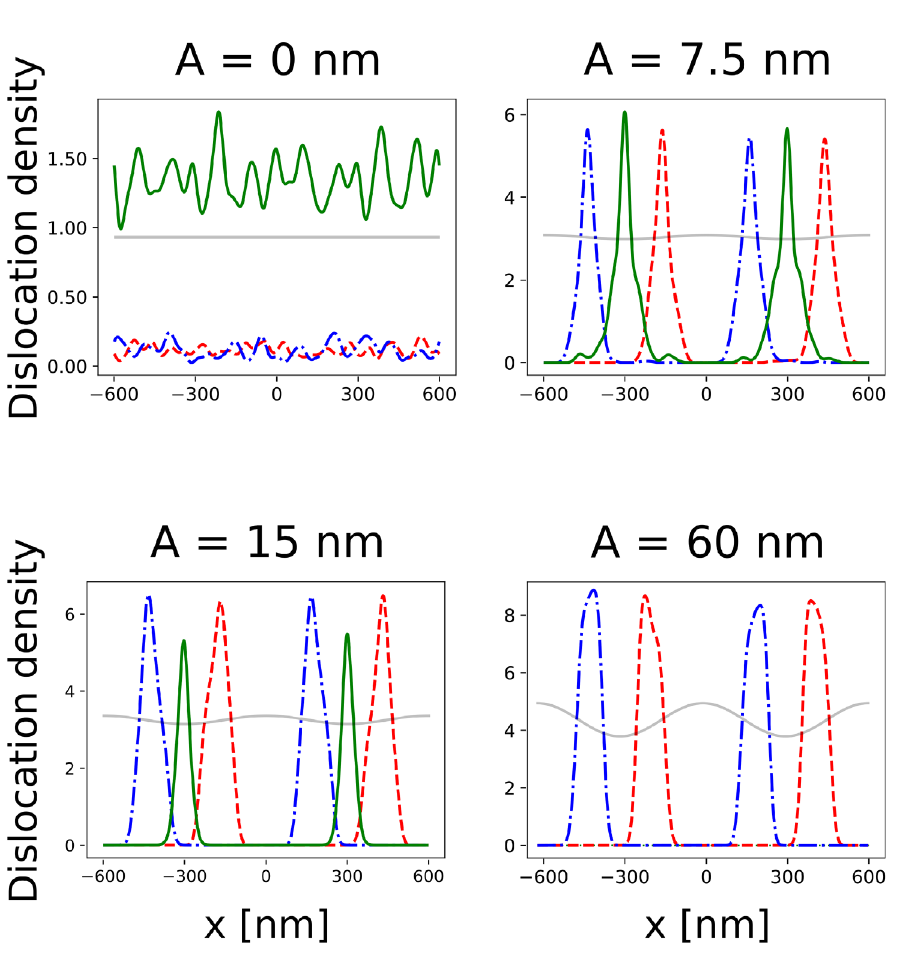
Figure 4. Dislocation density for different Burgers vectors as a function of the amplitude of the sinusoidal perturbation of the free surface (500 Monte Carlo searches each). Free surface profile is reported in transparency. As expected, for flat films (A = 0 nm) dislocations react and form edge dislocations (green solid line). Increasing the intensity of the perturbation, the density of 60 ◦ dislocations (red dashed and red dot-dashed lines) increase and they tend to localize near valleys in the free surface profile (A = 7.5 nm and A = 15 nm). At the highest perturbation value (A = 60 nm) the formation of edge dislocations is completely